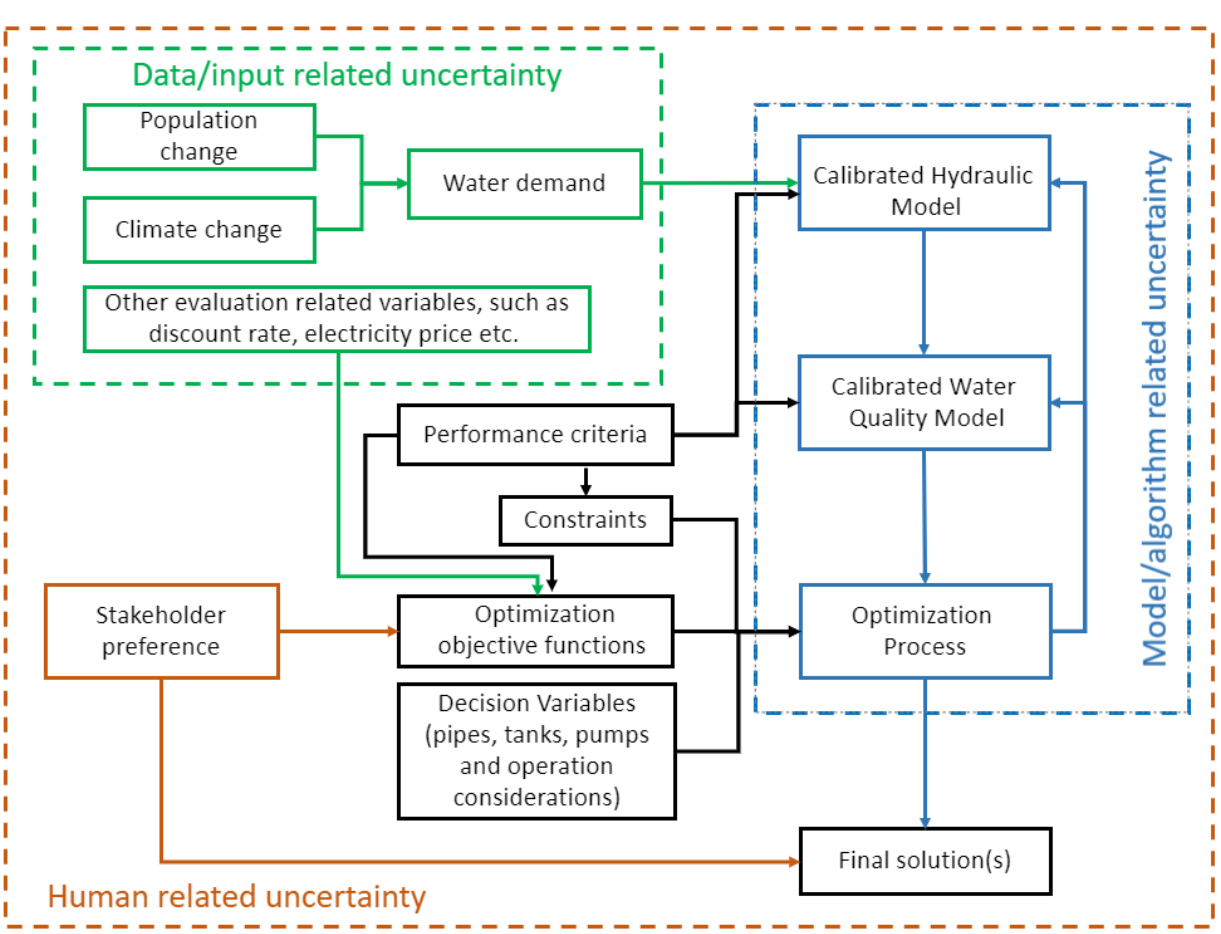
Figure 1. Steps involved in optimizing the planning, design or rehabilitation of WDS and the various sources of uncertainty.